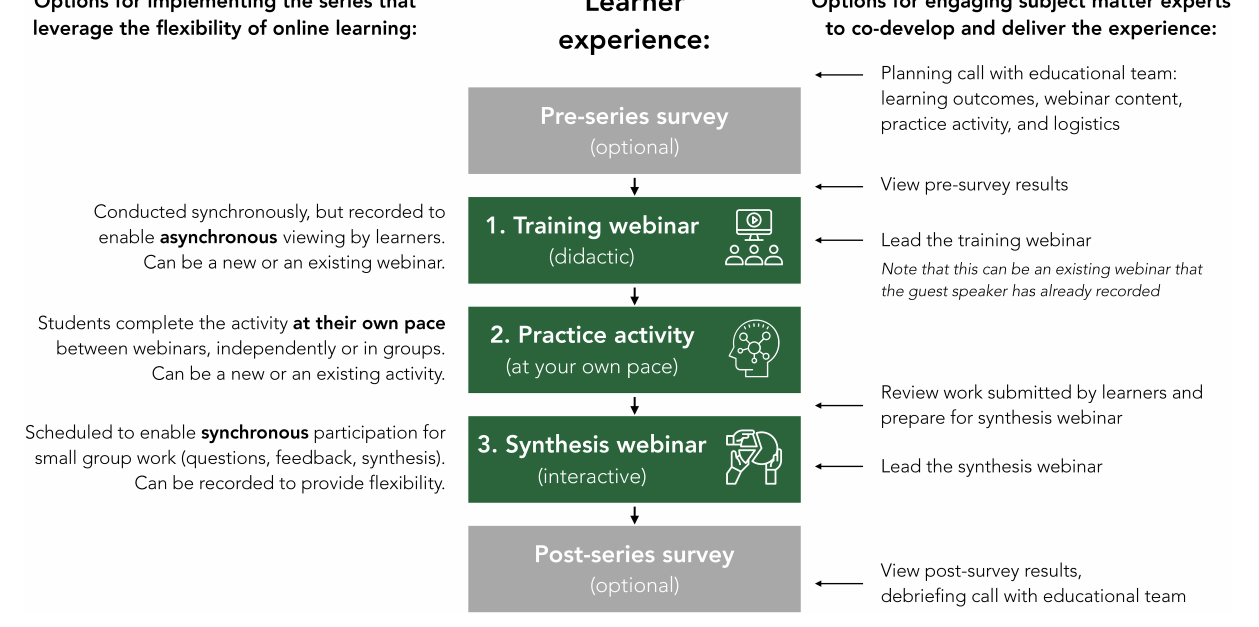
FIGURE 1 | The three-part webinar series format included a training webinar, a practice activity, and synthesis webinar. In developing and piloting the two series described in this paper, we used pre- and post- surveys to assess effectiveness and increase opportunities for engagement with subject matter experts. This figure describes ways the format can be implemented to leverage the flexibility of online learning, as well as possible points of contact with subject matter experts. This format is dynamic as educators and learners continue to